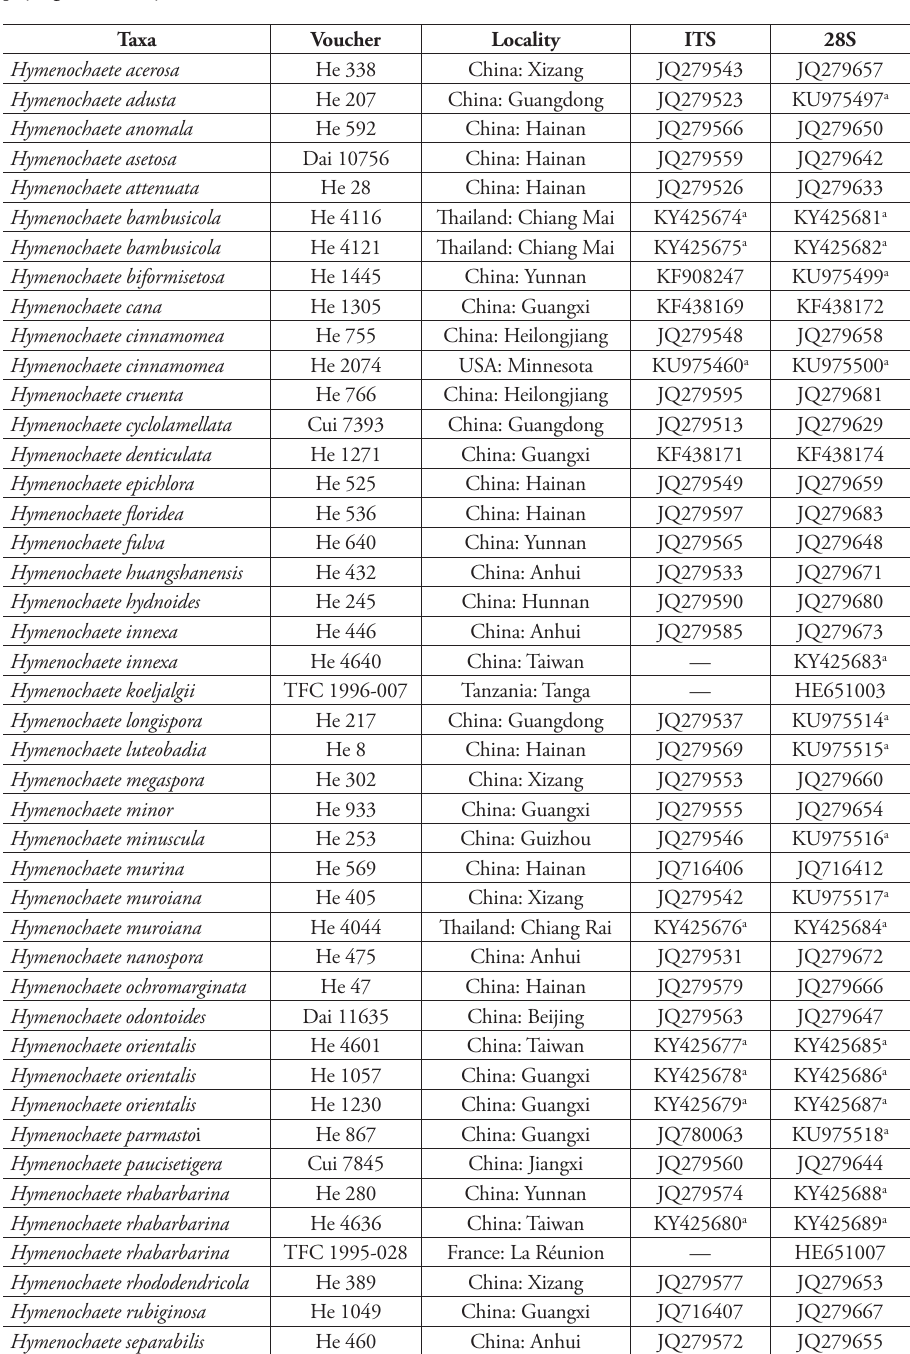
Table 1. Taxa with locality and GenBank accession numbers for ITS and nrLSU sequences used in the phylogenetic